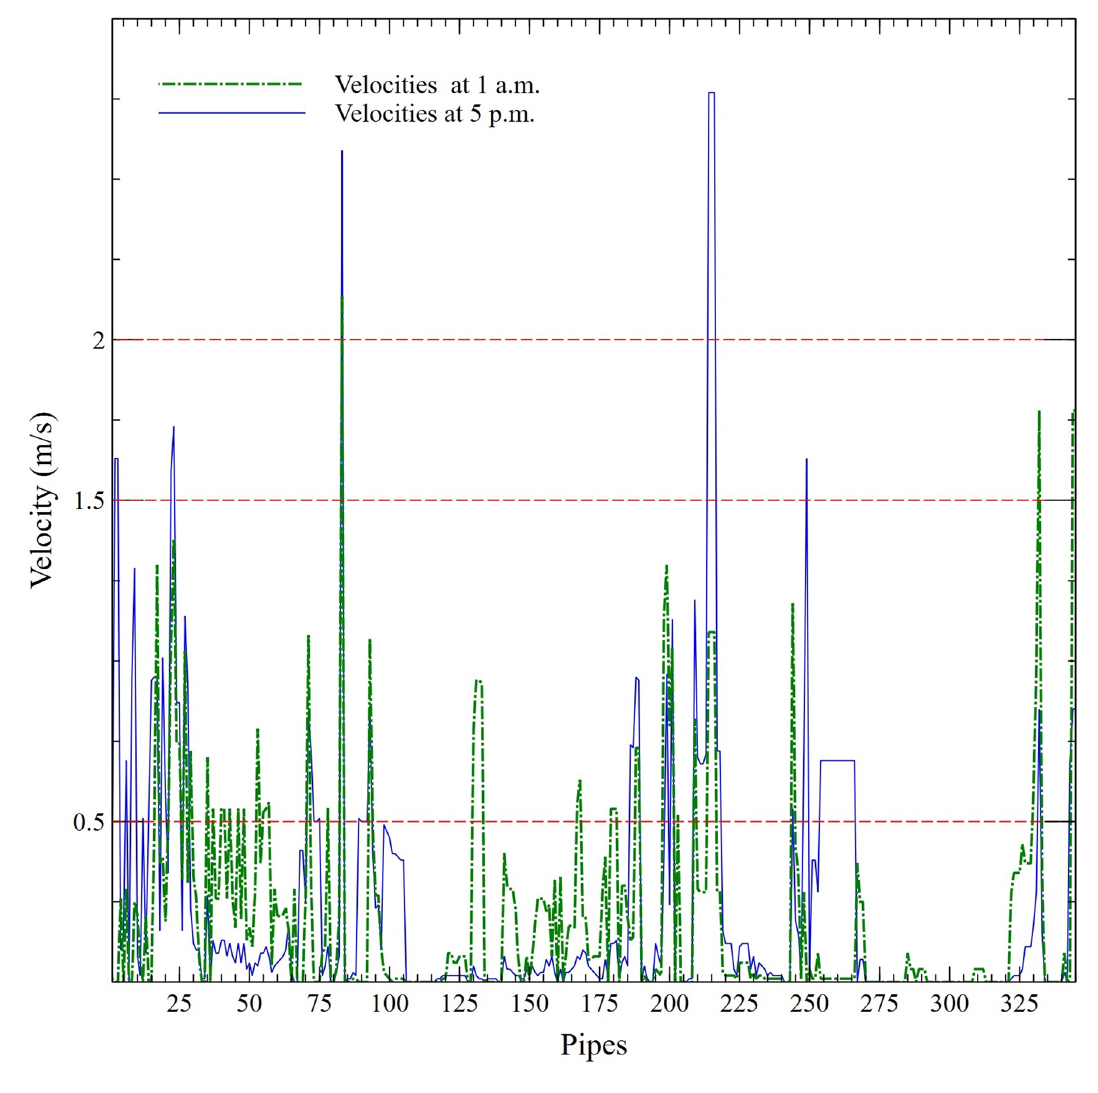
Fig. 10 Velocity fluctuations in the Goma's water supply network